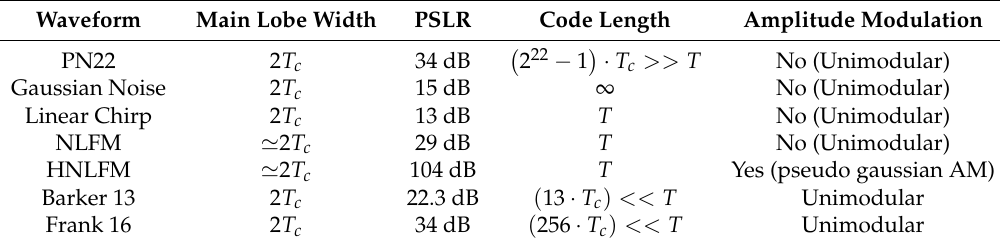
Table 4. Comparison of waveforms (the main lobe width, intended between its nulls, is expressed in terms of chip width, T c , while the PSLR is referred to the highest secondary lobe). All the waveforms show the same performances in terms of peak width due to the same − 3 dB